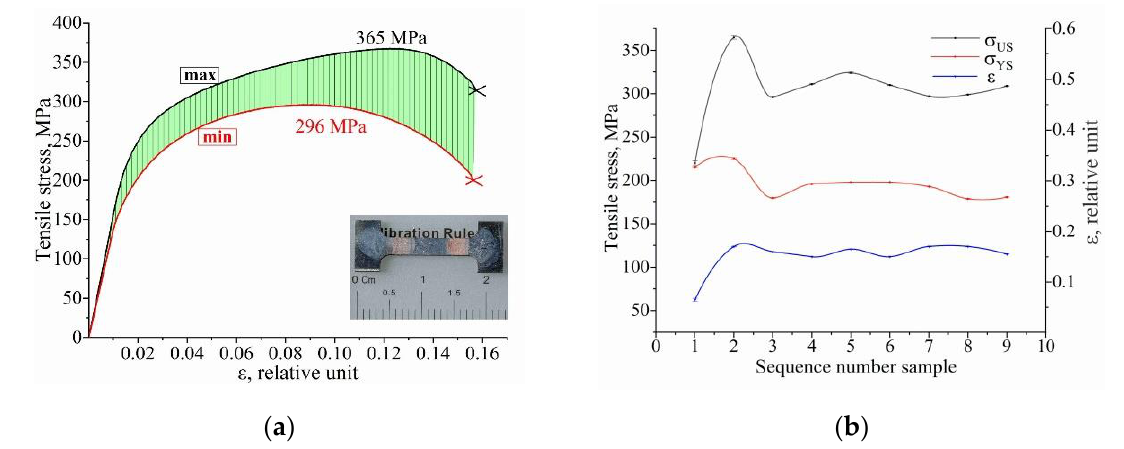
Figure 17. Results of uniaxial tension of bimetallic samples: ( a ) dependence of σ(ε) with minimum (red curve) and maximum (black curve) tensile strength; ( b ) experimental yield strength YS, ultimate strength US and deformation ε values of the samples.